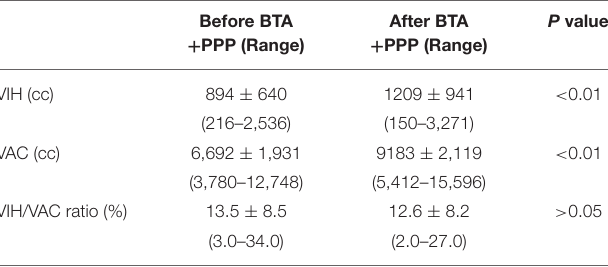
TABLE 3 | Comparison of peritoneal volumes before and after preoperative